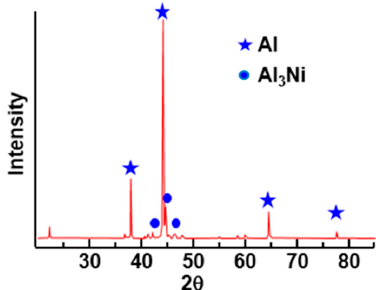
Figure 4. X-ray diffractometer (XRD) analysis result of coating that was hot-dipped at 690 °C for 120 s.